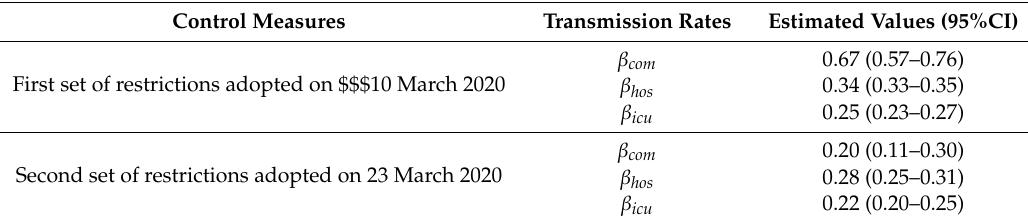
Figure 4. Modeling of control measures adopted on 10 March 2020 which were then intensified on 23 March 2020. Blue and red dots represent the number of reported ICU patients and deaths, respectively, while the lines represent their estimates and 95% confidence intervals through the SEIRD model. Grey lines, instead, represent the estimates in absence of control measures. Table 3. Transmission rates after the adoption of control measures.